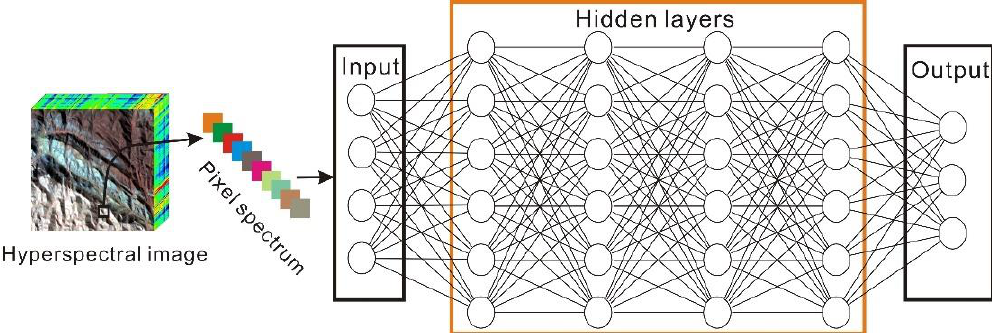
Figure 6. The FCNN structure for hyperspectral remote sensing data classification.